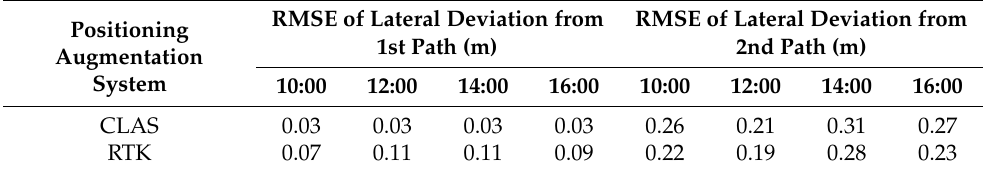
Table 5. Results from robot combine harvester controlled by CLAS.